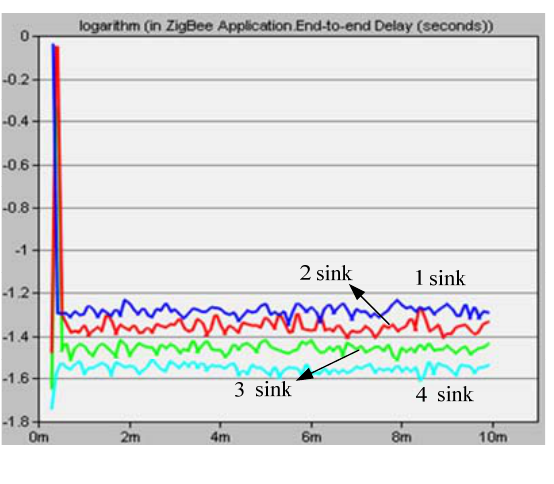
Figure 19. Network load for different sink